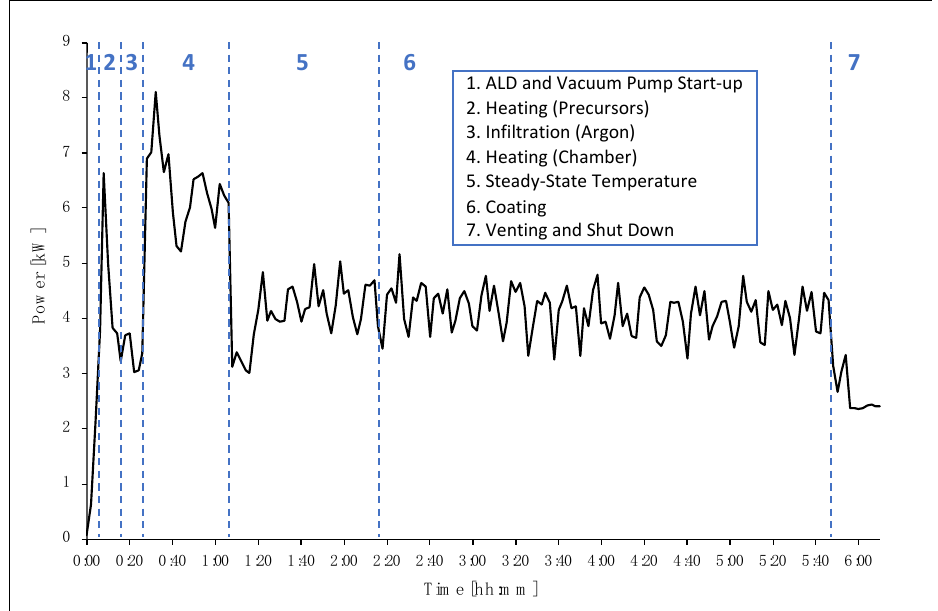
Figure 2. Power Consumption of the Thermal Atomic Layer Deposition Process (data measured at 2-s intervals; graph displays data averaged over 2-min intervals).